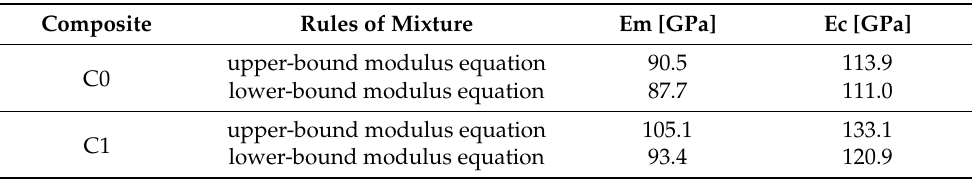
Table 5. Calculated elastic moduli of matrix alloys and composites C0 and C1, with and without SiC p . The rules of mixtures were used for the matrix alloys, and the Halpin–Tsai model was used for the composite